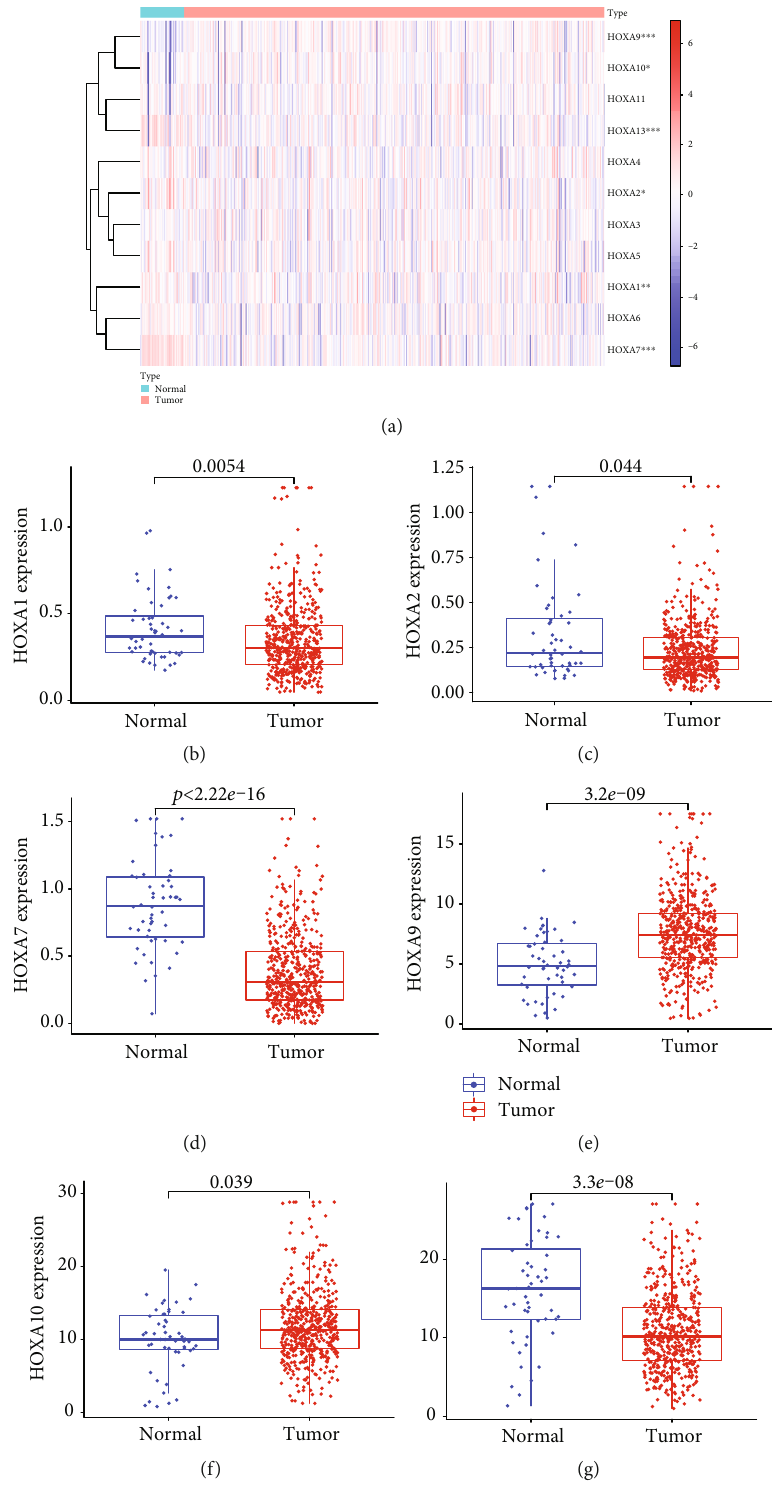
Figure 3: Expression pro fi le of HOXA members in PCa re fl ected via a heat map (a) and histograms (b –